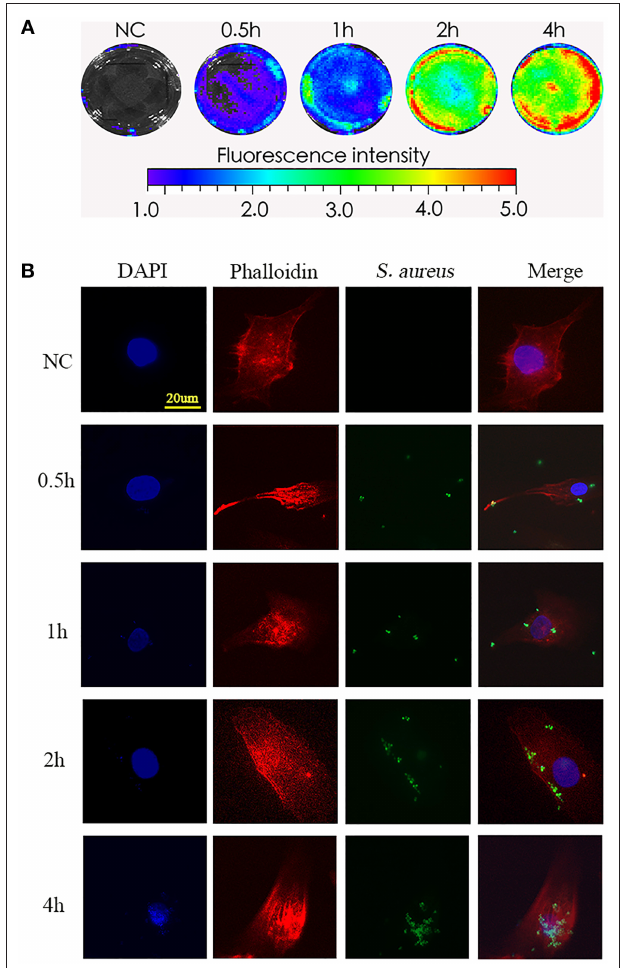
FIGURE 1 | Phagocytosis of S. aureus by NPCs in vitro . (A) NPCs were incubated with bioluminescent S. aureus strains (MOI = 1:10) for different time points (0, 0.5, 1, 2, 4h), and the bioluminescent intensity was detected using a Xenogen-Caliper IVIS-100 instrument. (B) NPCs were analyzed by confocal microscopy after incubation with GFP-labeled S. aureus for different periods at a MOI = 1:10. The scale bar represents 20 µ m. All micrographs are represented at least three experiments.